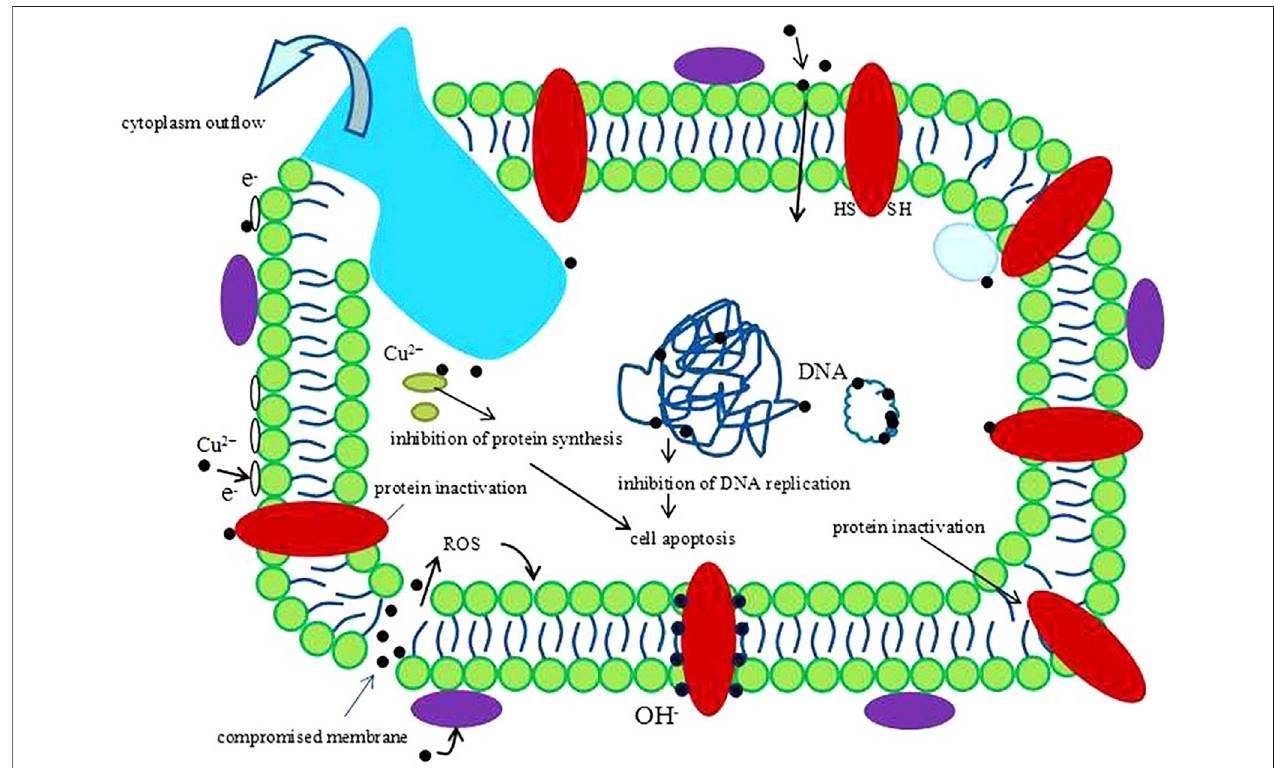
FIGURE1| AschematicimageofonehypothesisabouttheantibacterialmechanismofCu 2+ .Reprintedwithpermissionfromref.(Liuetal.,2016)(Copyright2016; Nature Publishing Group).